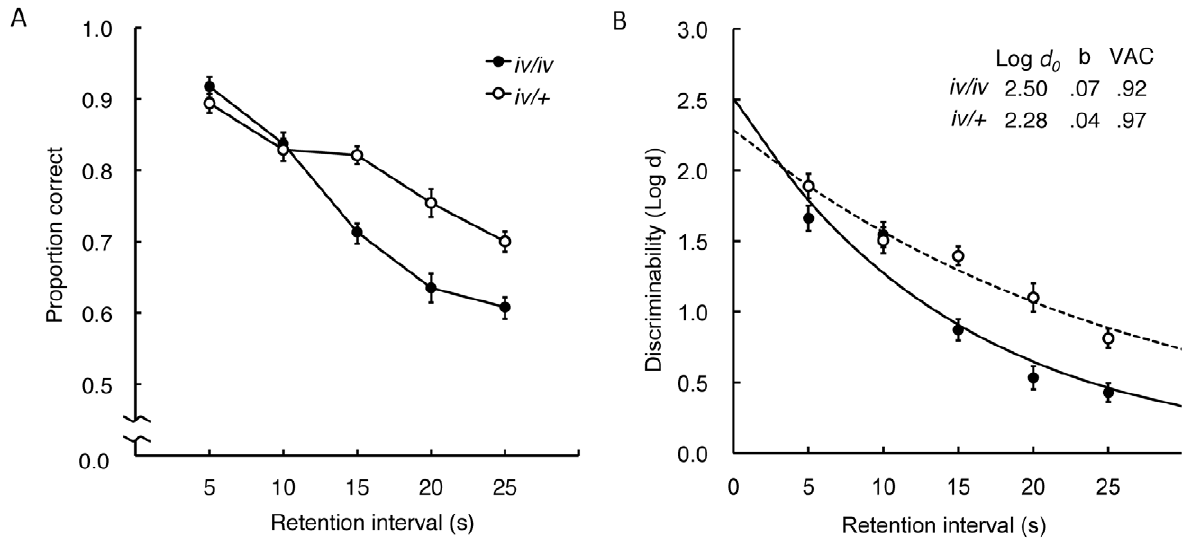
Figure 6. Retention accuracy of the delayed nonmatching-to-position (DNMTP). (A) The delayed nonmatching performance was evaluated using the proportion correct, calculated for 5-s bins of retention intervals (the length of time between sample and comparison responses) for iv/iv and iv/ + mice in the last 20 sessions. (B) Mean discriminability as a function of retention interval for iv/iv and iv/ + mice. Parameter values for the best- fitting exponentials (solid and dashed curves) are given for the two groups. The data are based on the performances in Test 3. Log d 0 indicates the discriminability at 0-s delay and b indicates the rate of forgetting. Measures of variance in the data accounted for (VAC) by the best fitting functions by Equation 2 indicate the fitting was satisfactory.